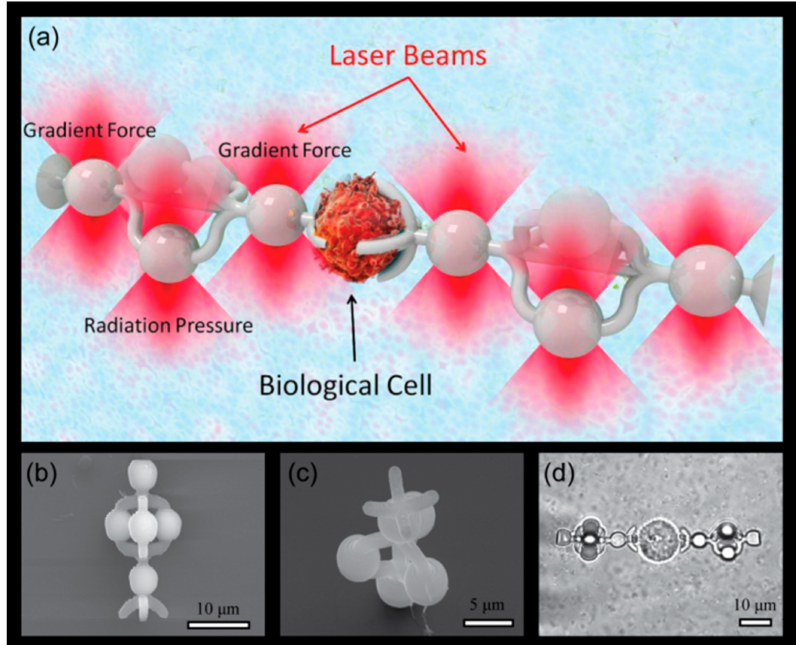
Figure 1. ( a ) An artist’s view of the cell clamps at work. The fork-like shaped clamps are optically trapped in 3D by holographic optical tweezers. Scanning electron microscopy (SEM) side view ( b ) and top view ( c ) of fabricated auxiliary microtools. ( d ) Microscope image of microtools engaged in immobilization of sw480 adenocarcinoma